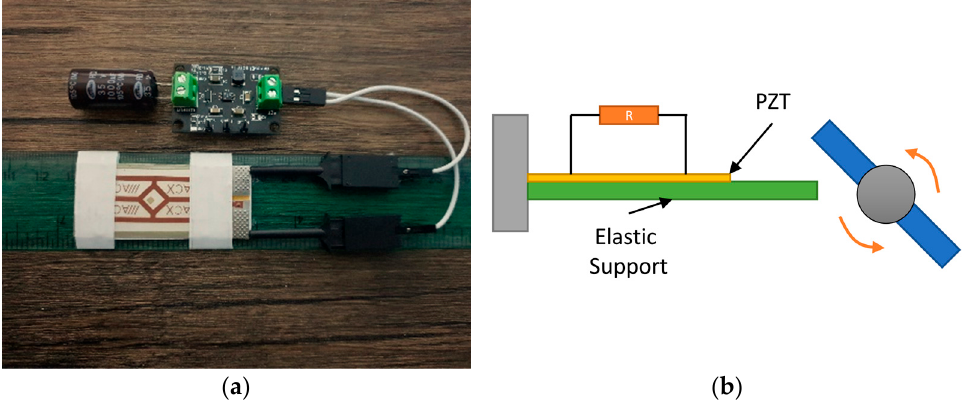
Figure 13. Way to collect piezoelectric energy: ( a ) mounting; ( b ) representation.